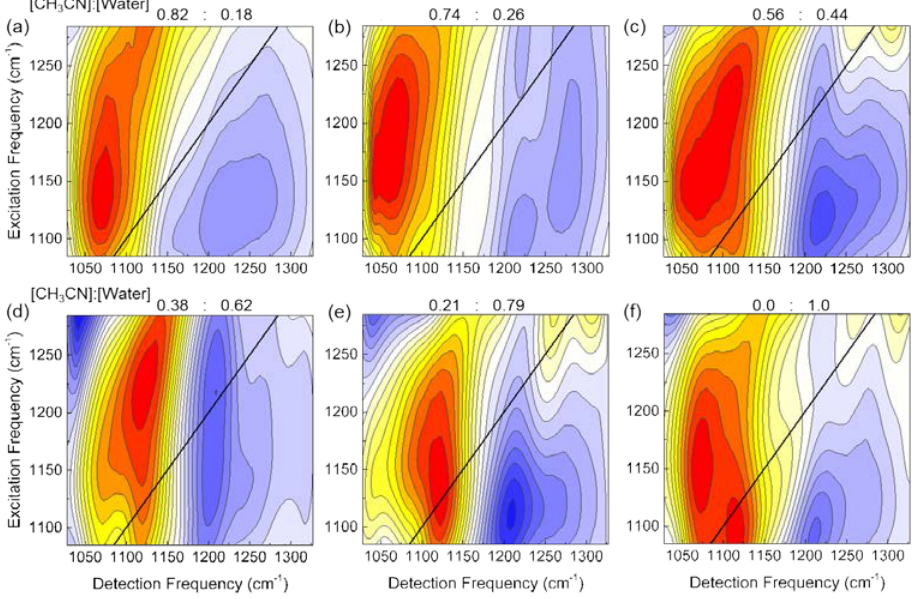
Fig. 2. (a-f) Series of 2D-IR measurements measured at T = 0 fs waiting time for HI in [CH 3 CN]: [H 2 O]